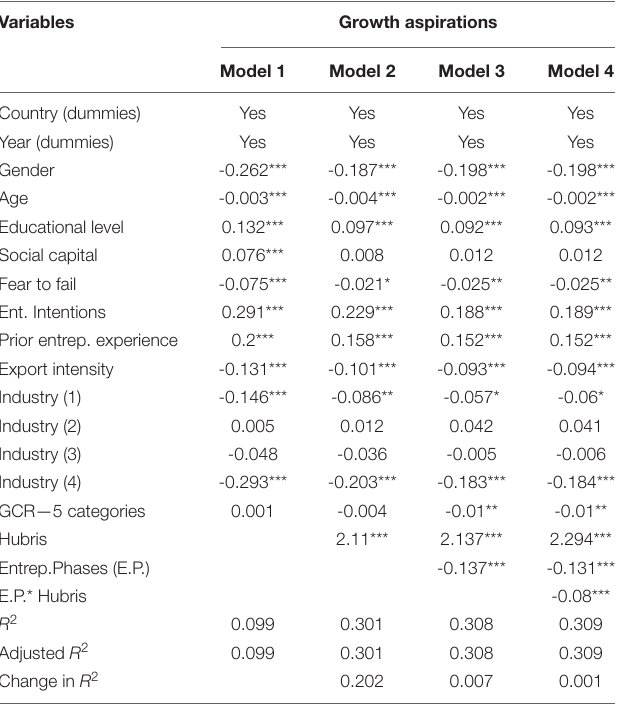
TABLE 3 | Results of the moderation effect of hubris and entrepreneurial process on growth aspirations.